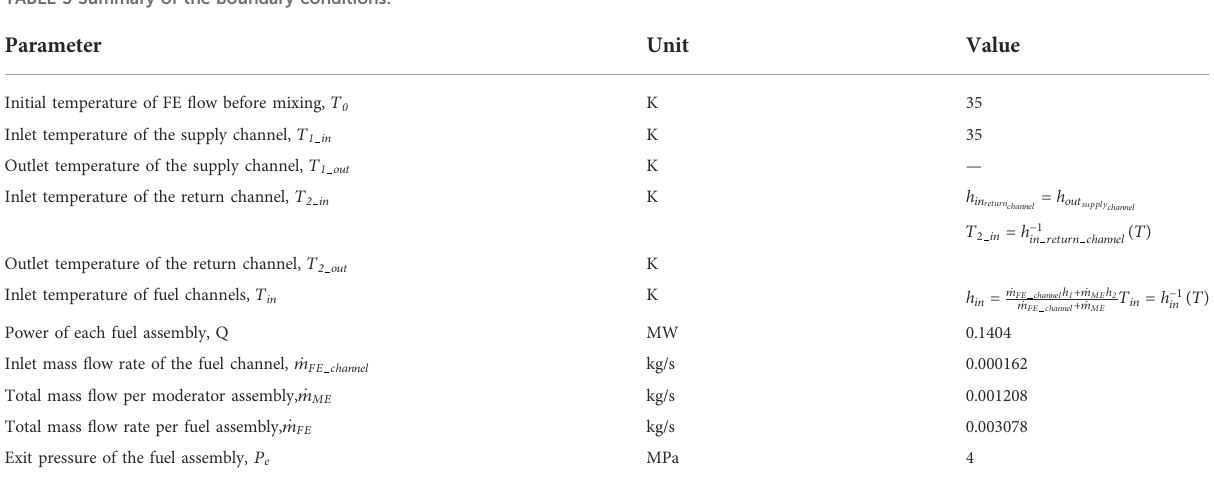
TABLE 3 Summary of the boundary